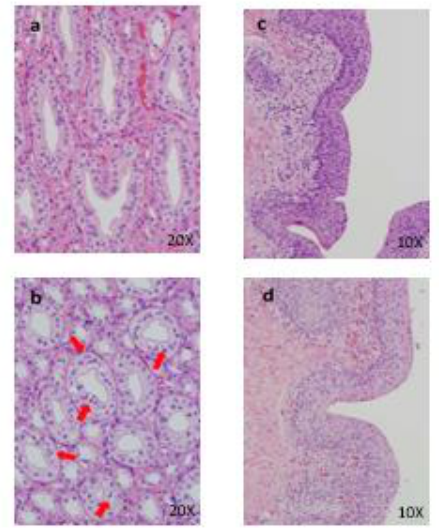
Figure 8: Histopathological findings in kidney. Control (a), 50 mg/kg (b), a , No abnormalities de- tected, b , Hyperplasia of mucosal epithelium are seen. Histopathological findings in urinary blad- der. Control (c), 50 mg/kg (d), c , No abnormalities detected, d , Hyperplasia of mucosal epithelium are seen.